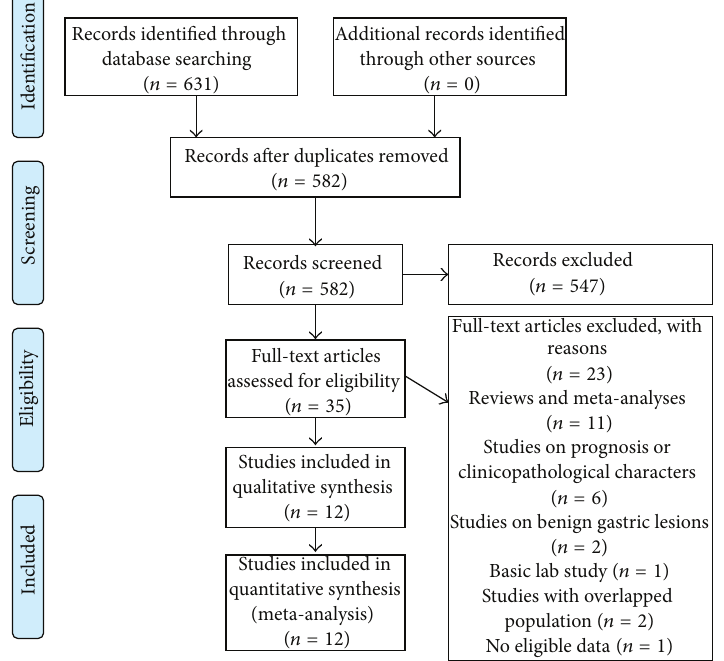
Figure 1: Flow diagram of study search and